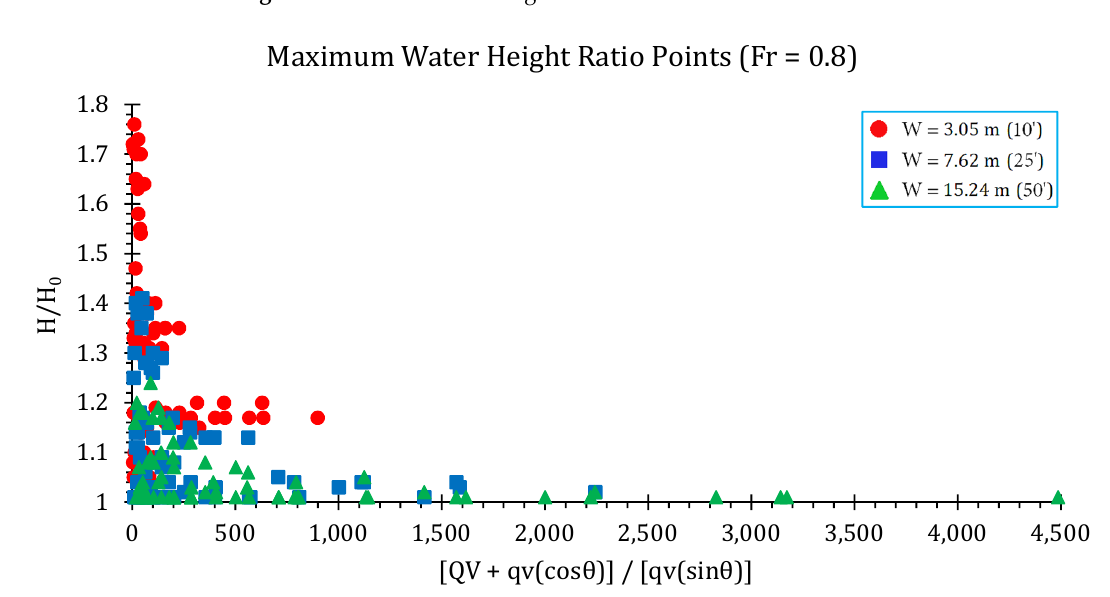
Figure 31. Conservative design curves for Fr = 1.2 in the channel.